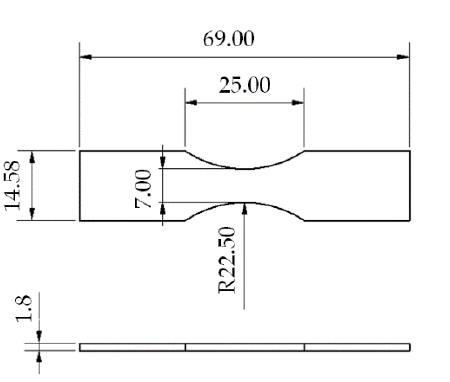
Figure 2. Used geometry of the fatigue specimen following DIN EN 3987 in mm.